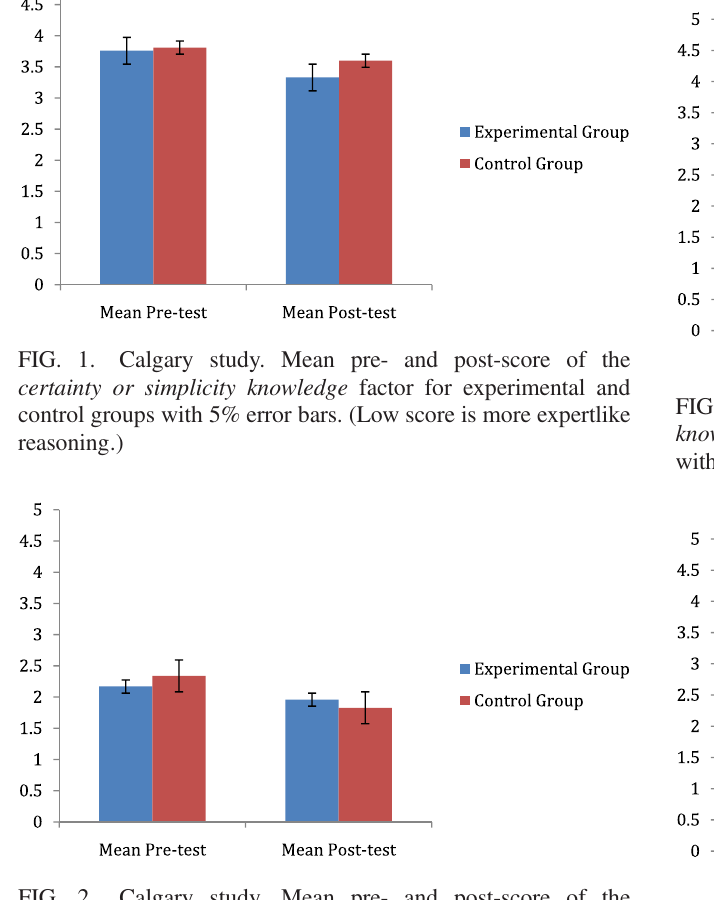
FIG. 4. Calgary study. Mean pre- and post-score of attainability of truth factor for experimental and control groups with 5% error bars. (Low score is more expertlike